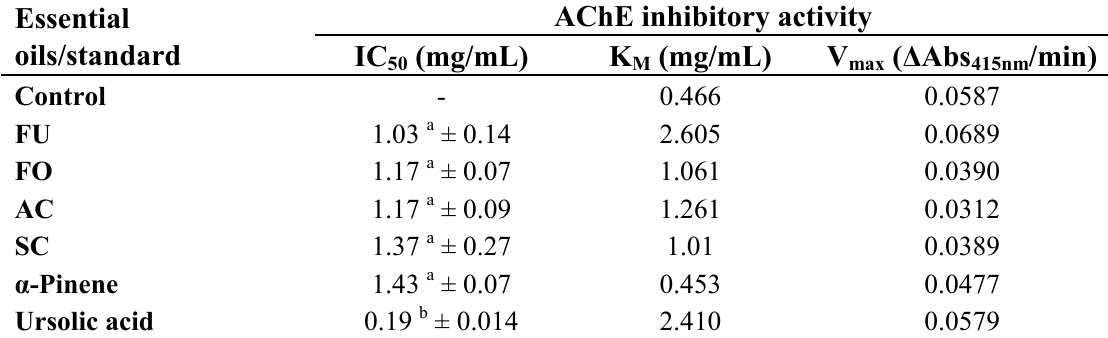
Table 2. Inhibition of AChE by essential oils from leaves of H. gardnerianum from four different sampling sites, and Standard compounds ( α -pinene and ursolic